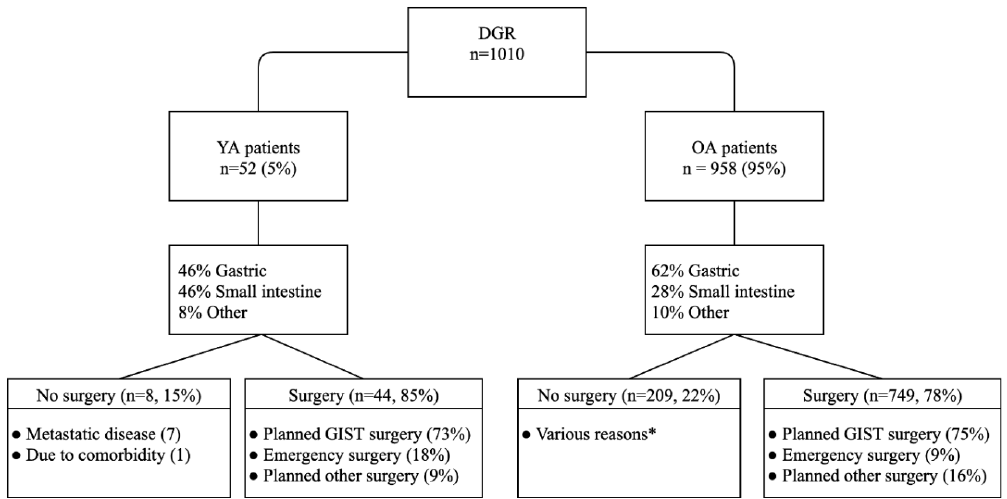
Figure 1. Study flowchart. * various reasons, such as metastatic disease, significant comorbidity, irresectable tumours or patients’ preference. DGR = Dutch GIST Registry; YA = young adult; OA